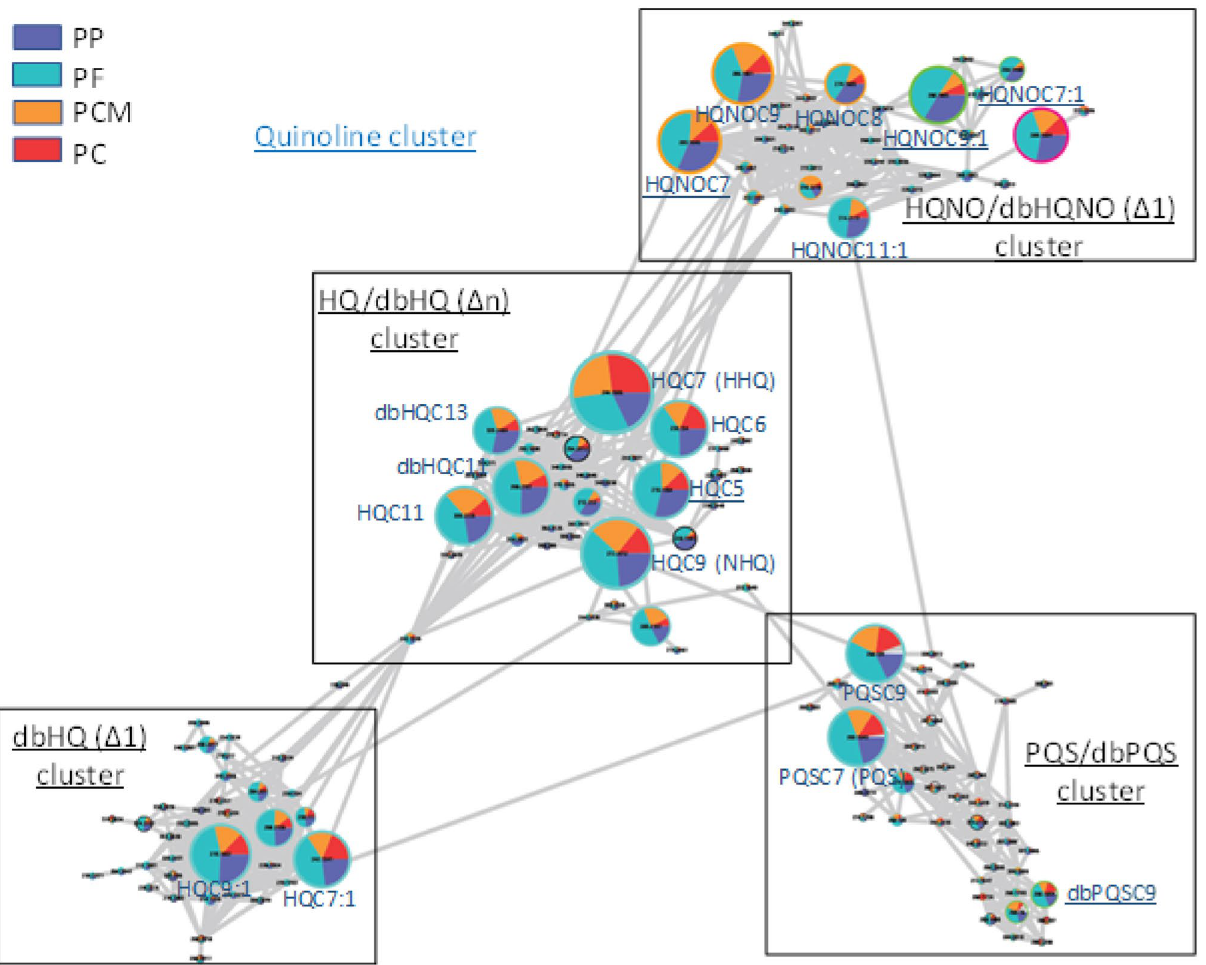
Figure 2. Quinoline cluster divided into 4 subclusters corresponding to different AQs classes : PP (strains from patients never colonised by Pa ; dark blue), PF (strains from patients not colonised by Pa during at least one year before; blue); PC and PCM (patient chronically colonised by Pa ; red and orange